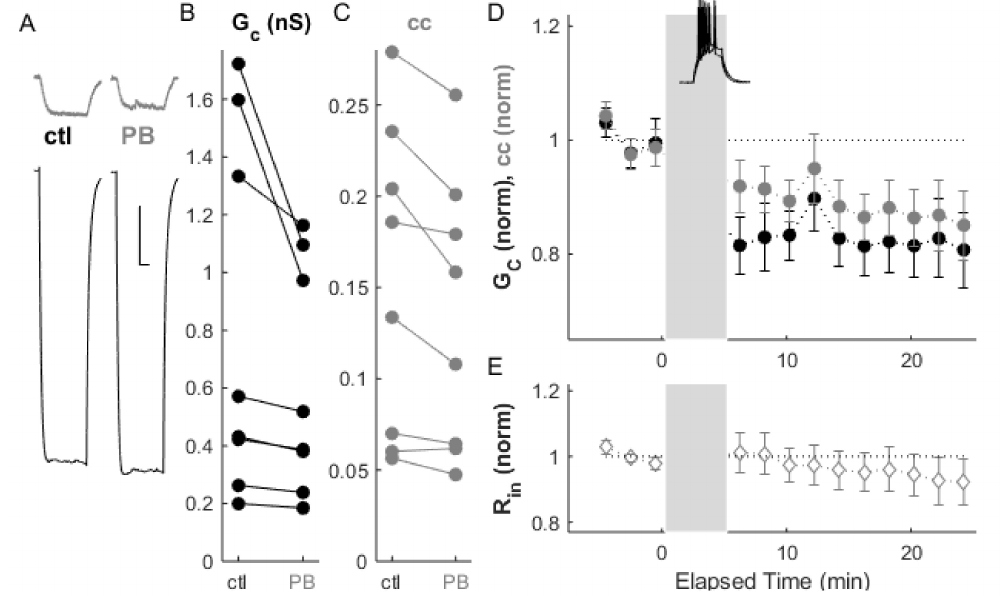
Figure 3. Bursts induce LTD of electrical synapses. ( A ) Example of paired recordings of electrically coupled neurons, in response to a − 100 pA step in one neuron (bottom), before and after 5 min of paired bursting (PB, inset in D ) activity in both neurons. Scale bar 100 ms, 5 mV (injected neuron), 10 mV (passive neuron). ( B ) Conductance G C and ( C ) and coupling coefficients cc for the cohort of pairs used in this experiment. ( D ) After paired bursting, ∆ G C (black) was depressed by 16.9 ± 0.8%, p w = 0.004, and ∆ cc (grey) decreased by 10.8 ± 1.4%, p w = 0.007 ( n = 8 pairs). ( E ) Input resistance for all neurons over the experiment.